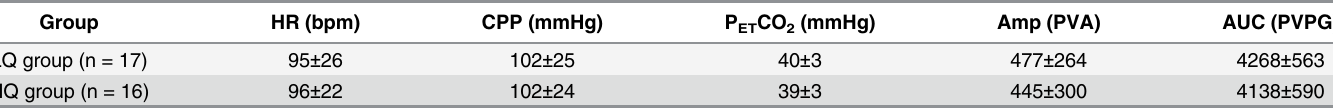
Table 1. Physiological parameters at